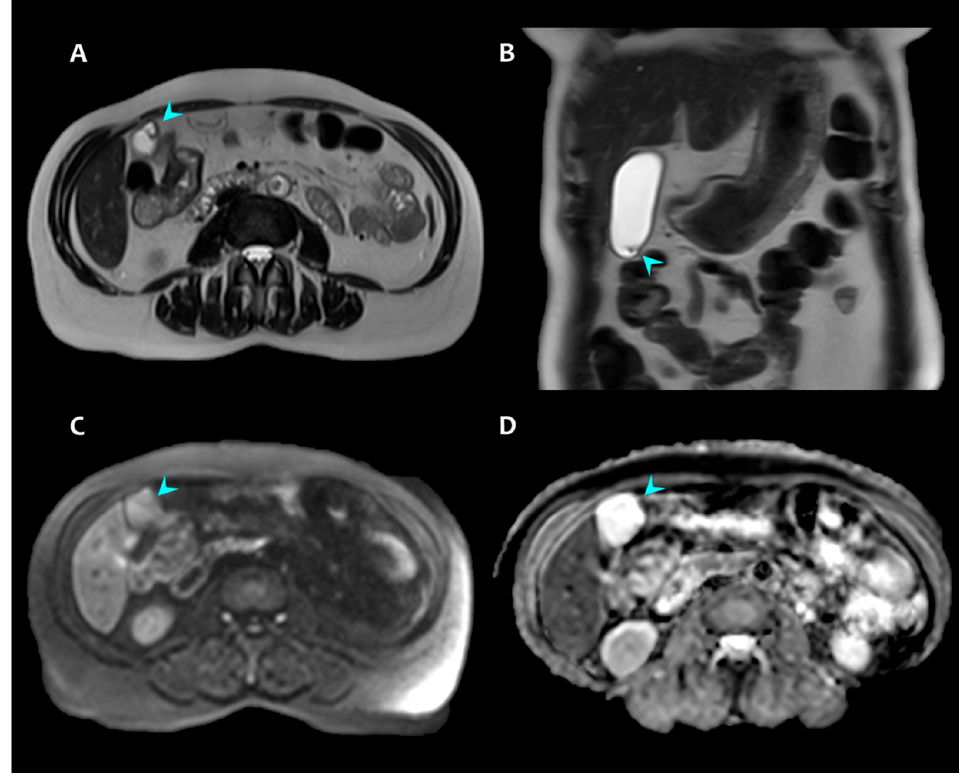
Figure 3. Imaging features of case #2, demonstrating a fundal cystic space with a linear endoluminal tissue component (teal arrowheads), representing a cyst wall or a septum. The tissue shows: T2-weighted MRI hypointensity ( A , B ); no MR-DWI restriction ( C ); no ADC hypointensity ( D ). Histopathology examination: Rokitansky-Aschoff sinuses (RAS) and cholecystitis.